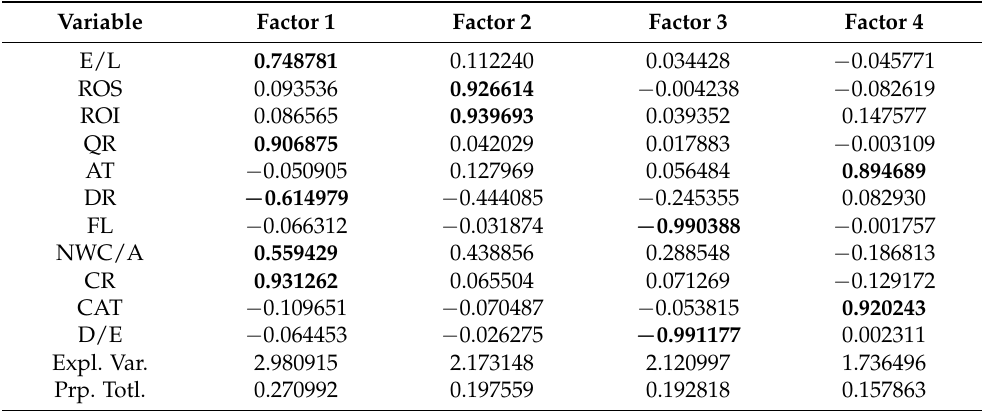
Table 6. Factor loadings after varimax rotation. Variable